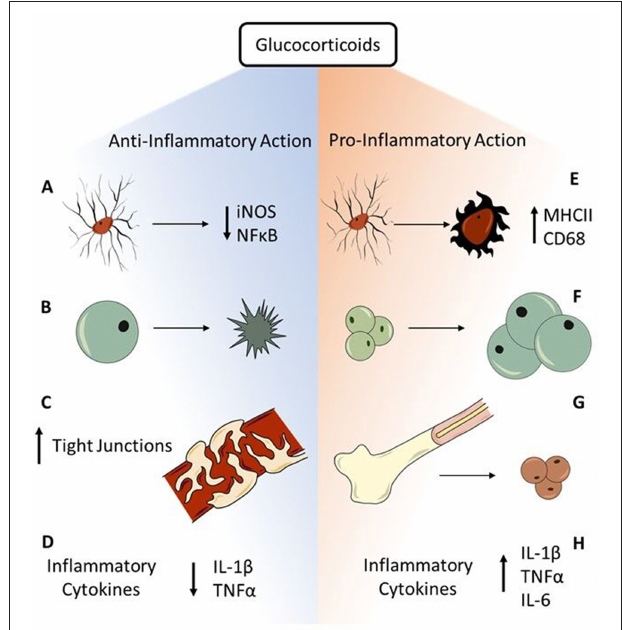
FIGURE 2 | Anti- and pro-inflammatory actions of glucocorticoids. GCs have robust immunosuppressive function through multiple avenues in acute response to stressors. (A) Microglia have high expression of GR, making them prime targets for GC immunosuppression. GR-mediated GC action is neuroprotective through decreasing microglial iNOS synthesis and preventing NF κ B activation. (B) The adaptive immunity effector cells, T-cells, go through GC-mediated apoptosis that prevents perpetuation of inflammatory responses. (C) Endothelial cells of the BBB express GR. Binding of GC to GR contributes to tightening of BBB tight junctions and improves BBB integrity to prevent peripheral immune cells from entering the brain. (D) The major anti-inflammatory mechanism of GCs is GR-mediated genomic immunosuppression through decreasing expression of inflammatory cytokines including IL-1 β and TNF α . While GCs are primarily immunosuppressive in the face of acute challenges, chronic stressors reveal pro-inflammatory actions of GCs. (E) GR-rich microglia are susceptible to stress-induced priming, shown through increased CD68 and MHCII expression, resulting in a hyper-reactive response to subsequent immune challenge. (F) Though GCs induce T-cell apoptosis, GCs also enhance lymphocyte maturation through increasing T-cell sensitivity to IL-2, contributing to a pro-inflammatory environment. (G) GC production via the chronic stress of repeated social defeat mobilizes monocytes from the bone marrow, contributing to neuroinflammatory consequences such as increased anxiety. (H) GCs also increase circulating